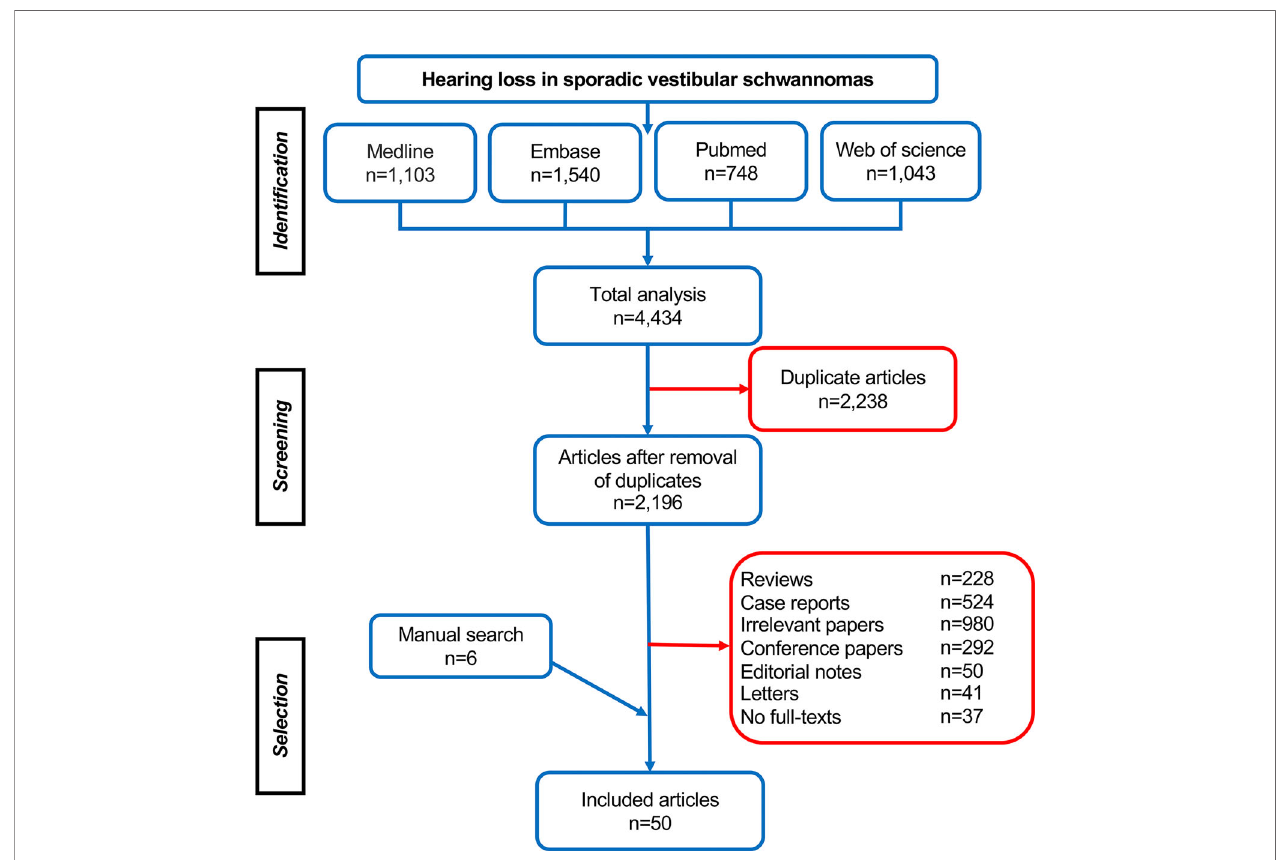
FIGURE 1 | Study selection and